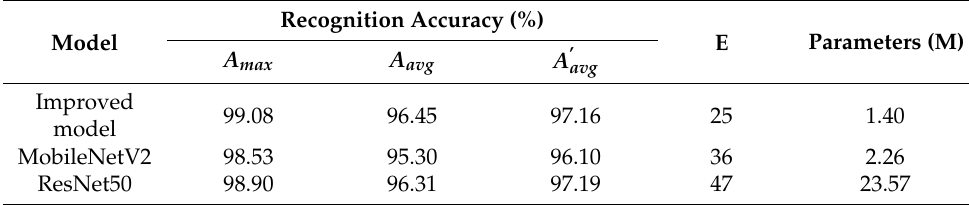
Table 3. Comparison of experimental results of each model on the self-built dataset.